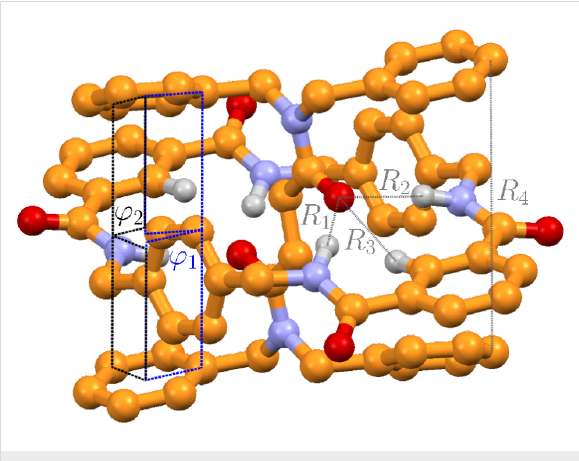
Figure 2: Molecular geometry of one rotaxane optimized in periodic boundaries at the PBE-D3/1000 eV level. Hydrogen atoms are omitted for clarity. Some intramolecular distances and angles are